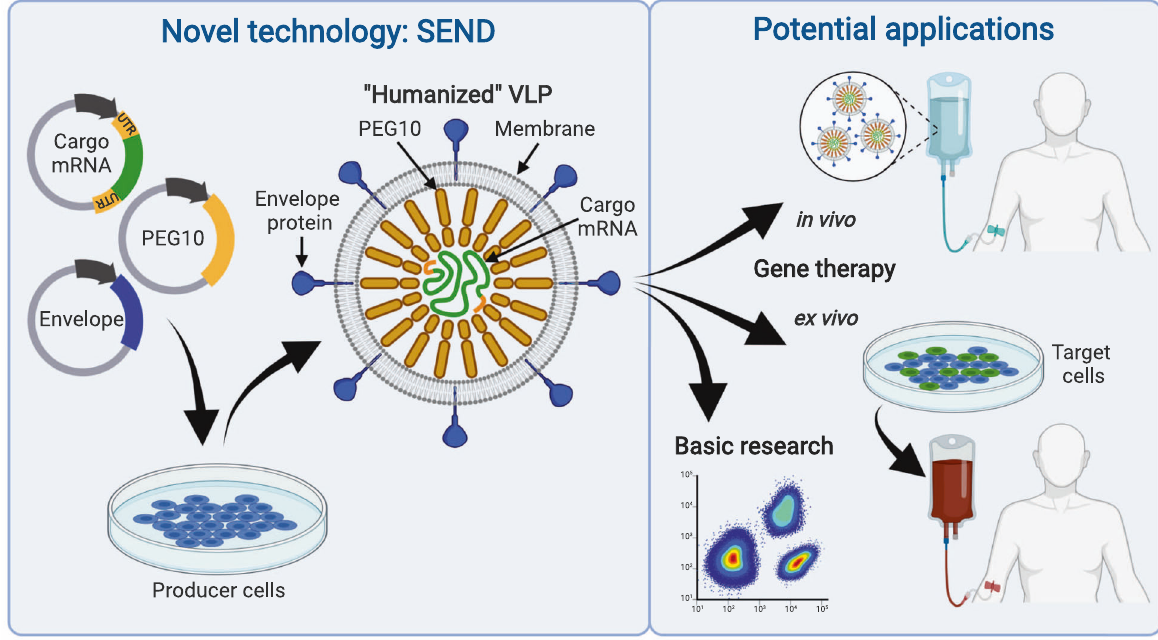
Fig. 1 Illustration of the principle and potential applications of SEND (selective endogenous encapsidation for cellular delivery). The virus-like particles (VLP) are generated by transfecting three plasmids into producer cells. One of the plasmids transcribes the cargo mRNA, an mRNA of the gene to be delivered (green) fl anked by the untranslated regions of PEG10 (orange, labeled “ UTR ” ) which serve as packaging signal. The second plasmid expresses endogenous PEG10 (orange, without its original UTRs), which facilitates VLP formation and binds the cargo mRNA at its UTRs. The third plasmid expresses a fusogenic envelope-protein-like VSVg (viral origin) or SYNA (endogenous). Functional VLPs are released into the medium and can be puri fi ed for future use. On the right side, potential applications of the novel technique are depicted. If preclinical tests con fi rm ef fi ciency and safety, the endogenous VLPs could be suitable for in vivo or ex vivo gene therapy applications in the future. In any case, this novel vector system will spur basic research. Illustration created with